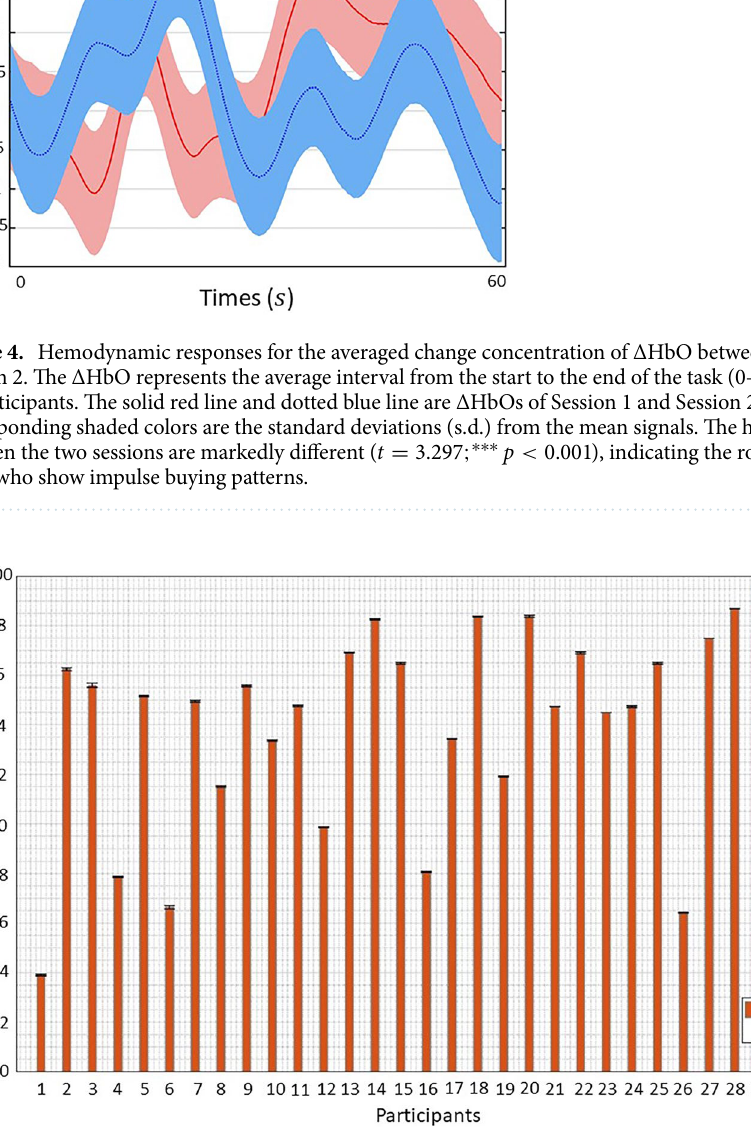
Session 1 (red lines) shopped in an online duty-free shop environment with Session 2 (blue lines) shopped in an online shopping mall environment. Their s.d. is expressed in red shading in Session 1 and blue shading in Session 2, respectively. The signal difference between the two sessions is significant ( t = 3.297, ∗∗∗ p < 0.001 ) statistically, indicating that the ∆HbOs gap between the two sessions is enormous. Thus, this finding can be used to forecast impulse buying trends.